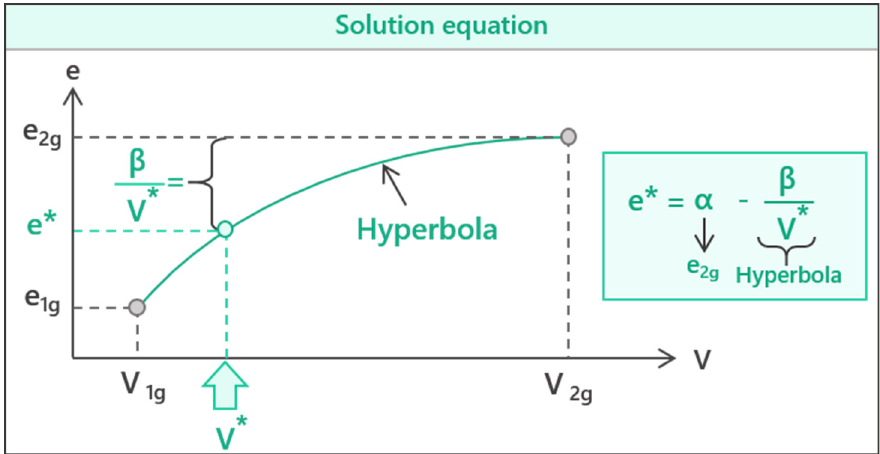
Figure 10. Solution of the specific energy e* of the example case, where the station would combine n g = 1 and n g = 2.